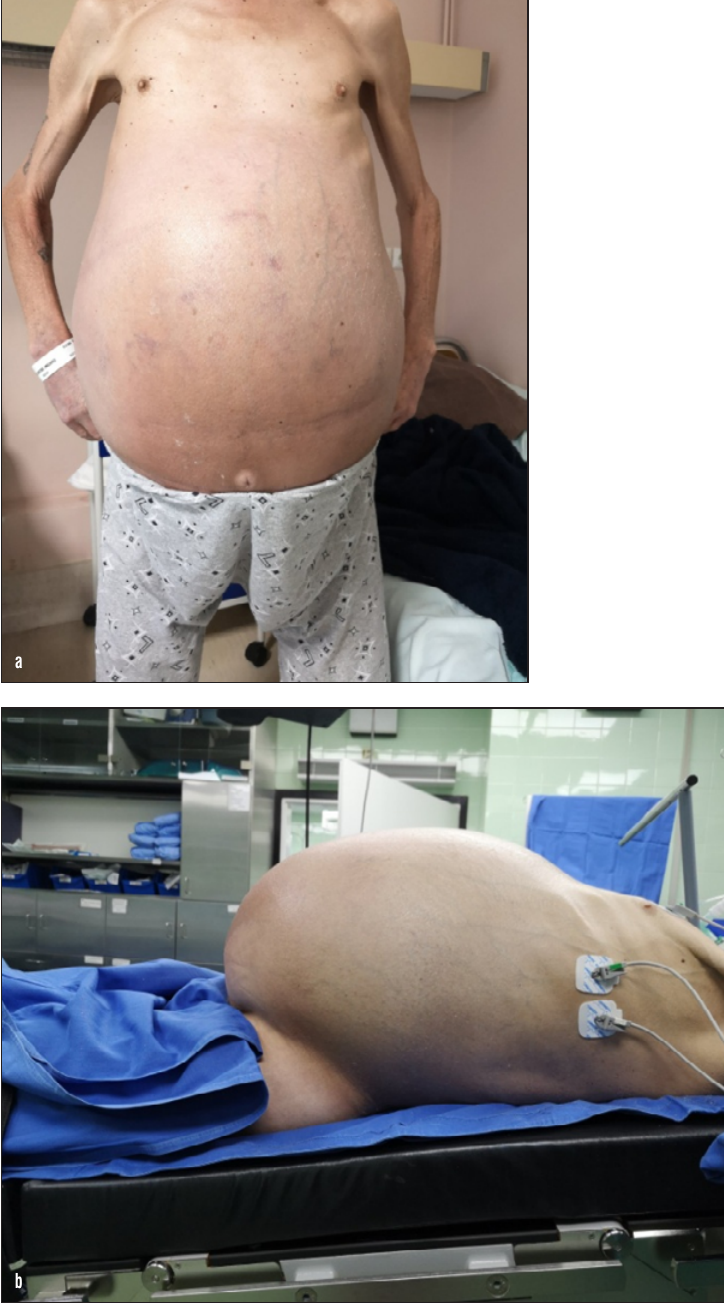
Figure 1. Distended abdominal